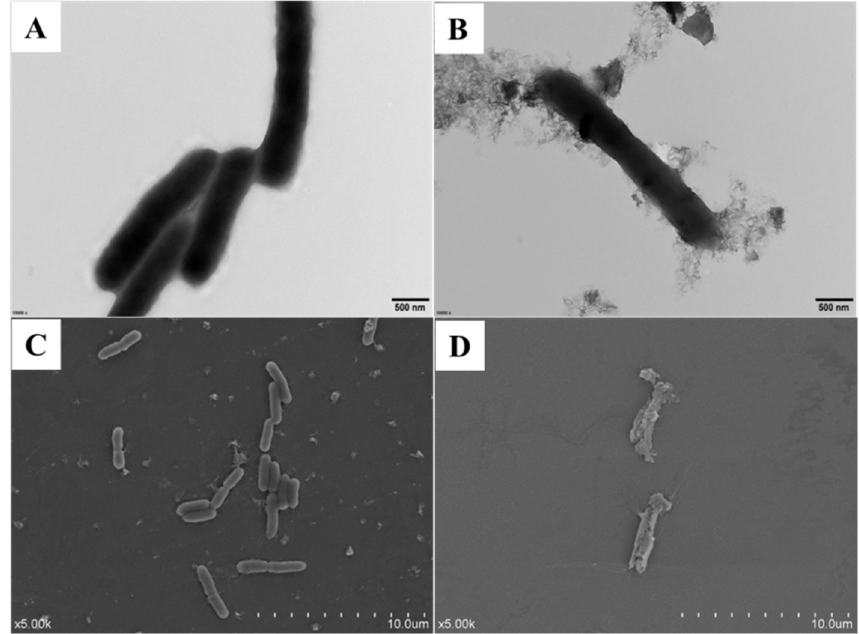
Figure 7. TEM images of Salmonella untreated ( A ) or treated with ( B ) 125 µ g / mL MnO 2 nanosheets. Scale bars: 500 nm. Scanning electron microscopy (SEM) images of Salmonella untreated ( C ) or treated with ( D ) 125 µ g / mL MnO 2 nanosheets. Scale bars: 10 µ m.